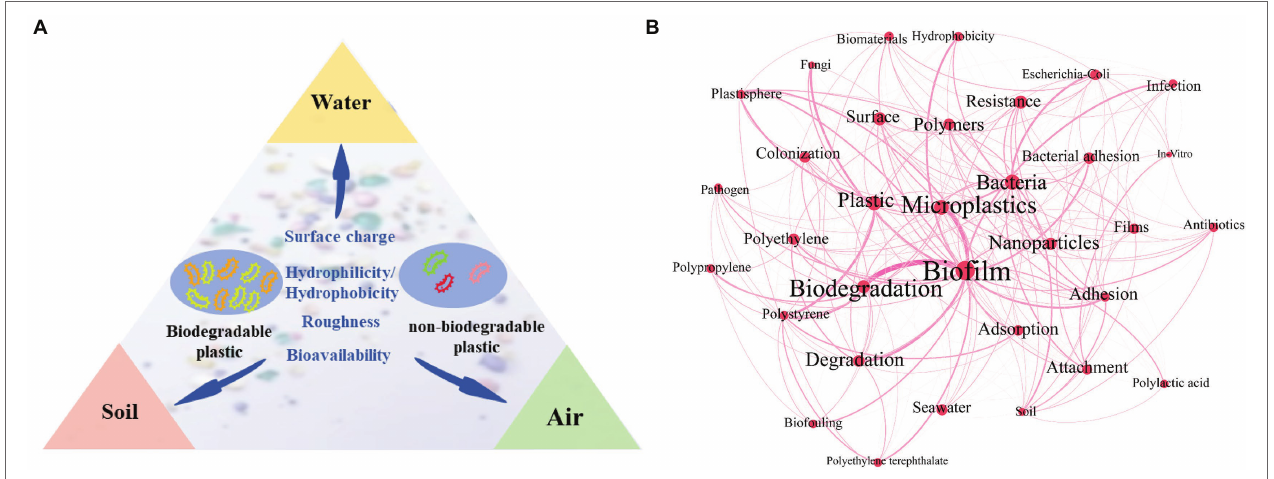
FIGURE 1 | Microbial differences in the biodegradable plastisphere and non-degradable plastisphere in three environments (air, water, and soil; A ). Co-occurrence network analysis of plastic- and biofilm-related keywords in current studies (B) . Each keyword on the map is displayed as a node, with size determined by the occurrence. Keyword relationships are shown as edges of varying thickness determined by the